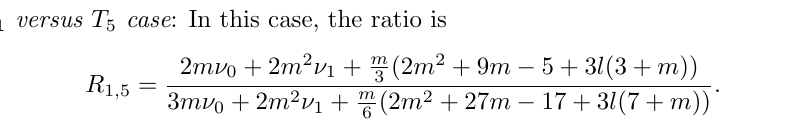
Figure 1. Boundary lines for comparison of T 1 and T 3 .